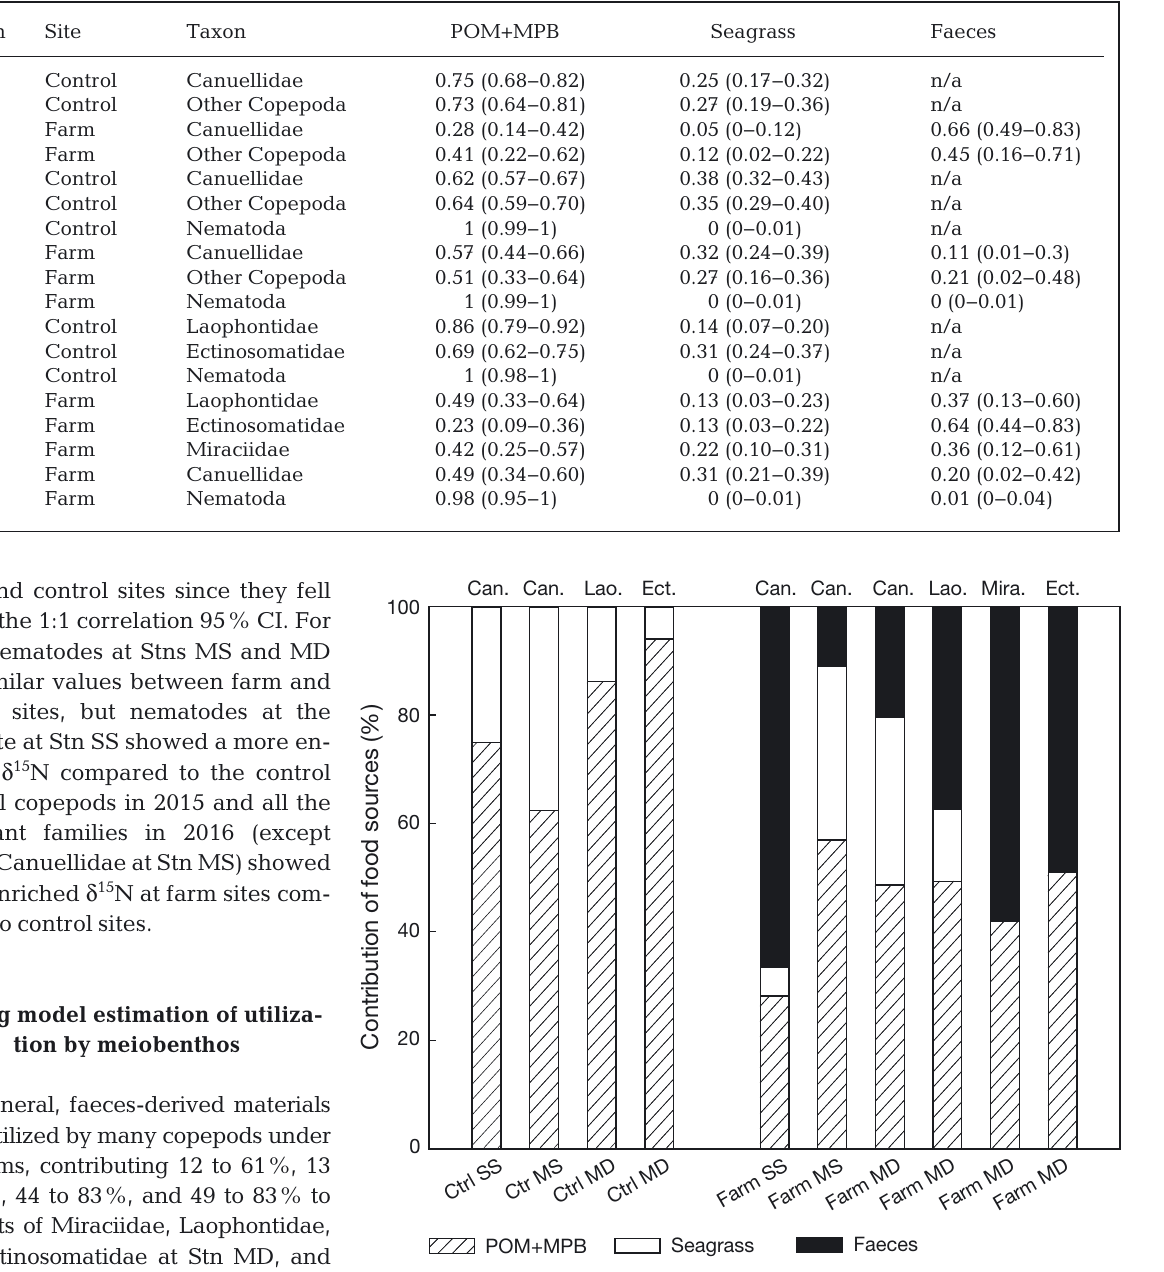
Table2.Contribution (mean, with 95%CIs in parentheses) of particulate organic matter plus microphytobenthos (POM+MPB), seagrass and faeces in the diet of meiobenthos taxa collected from ‘farm’ and ‘control’ sites at 3 stations at scallop farms in Laizhou Bay, China in 2015 and 2016. See Table 1 legend for abbreviations of stations. The values were calculated using the Bayesian stable isotope mixing model (MixSIR). n/a: not applicable